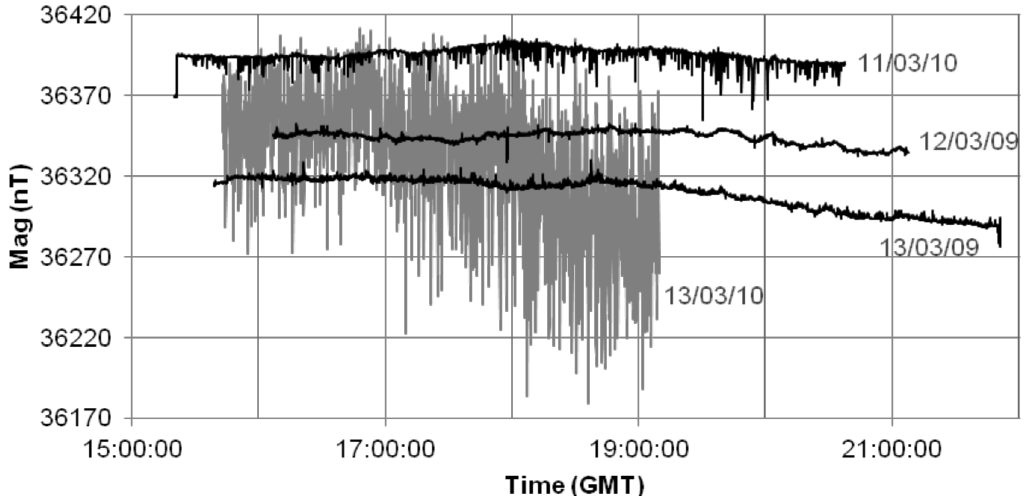
Figure 5: Record of magnetic diurnal variation on 4 di ff erent days in 2009 and 2010. Location: 12°00’02.65"N, 86°09’03.63"W or 16P 592423 1326777. of fault